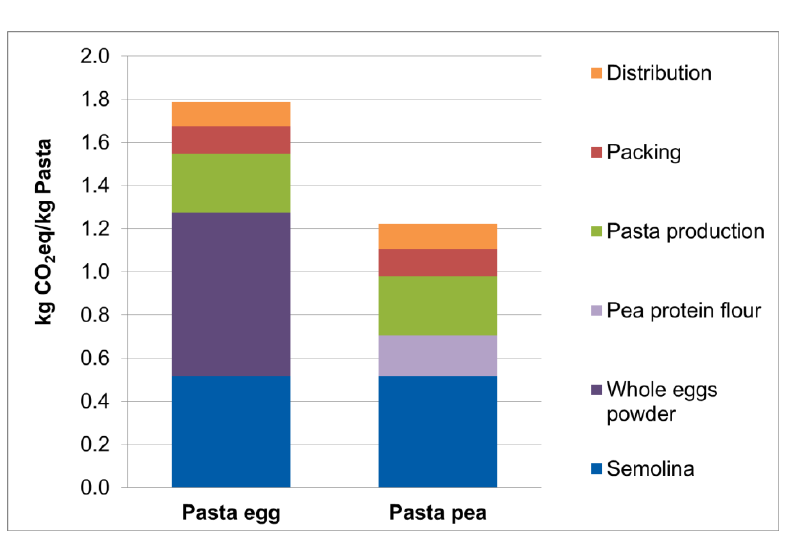
Figure 3. Carbon footprint of different pasta types.